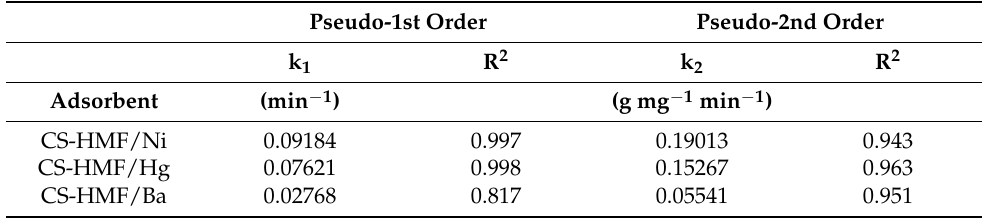
Figure 4. Kinetic data for the uptake of Ni 2+ , Hg 2+ , and Ba 2+ from aqueous solutions (single-component). Fitting to pseudo-1st and pseudo-2nd order equations. Experimental conditions: T = 25 °C, C 0 = 120.0 mg/L, N = 160 rpm, V = 20 mL, m = 0.02 g, pH = 6. Table 1. Pseudo-1st and pseudo-2nd order equations for the uptake of Ni 2+ , Hg 2+ , and Ba 2+ from aqueous solutions (single